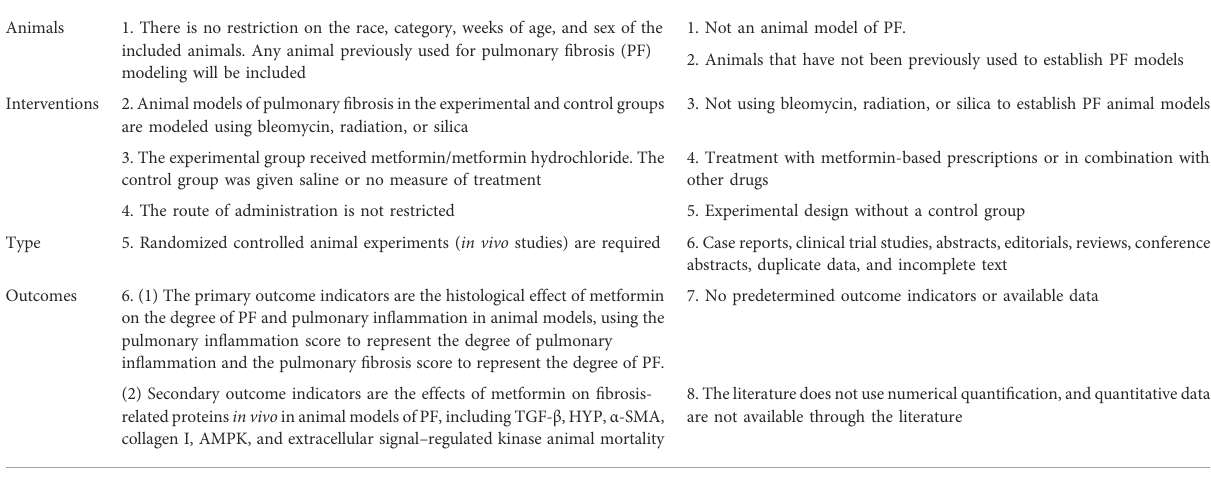
TABLE 1 Inclusion and exclusion criteria.